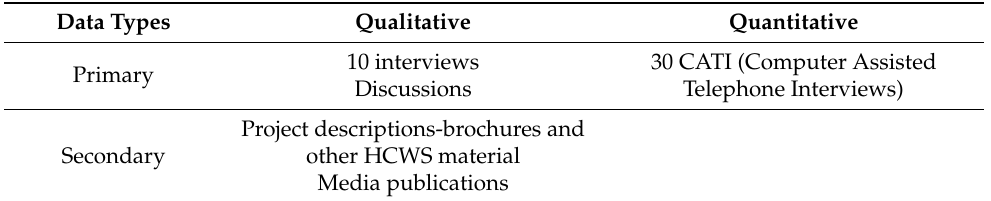
Table 4. An overview of the data collection methods in this